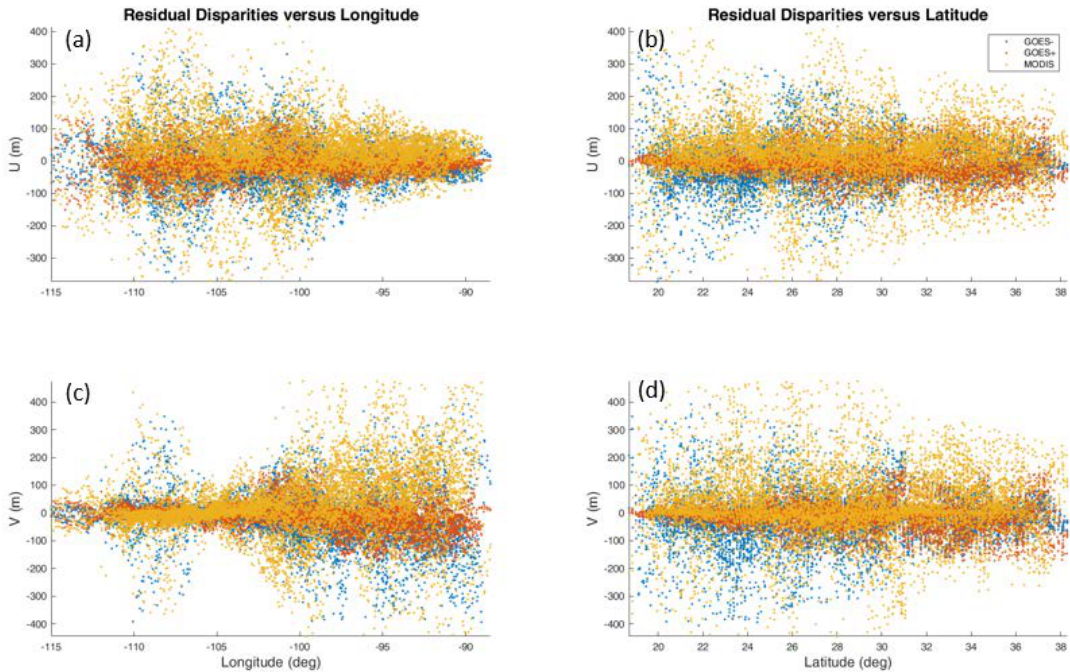
Figure 9. Residual disparities in the tangent plane after retrievals after correcting for the BBR o ff sets (versus longitude ( a , c ) and latitude ( b , d )). The case shown is MODIS granule MYD2019057.2000.061 (band 31) paired with GOES-16 CONUS ABI band 14. For context, the ground footprint of an ABI band 14 pixel is 2 km at the subsatellite